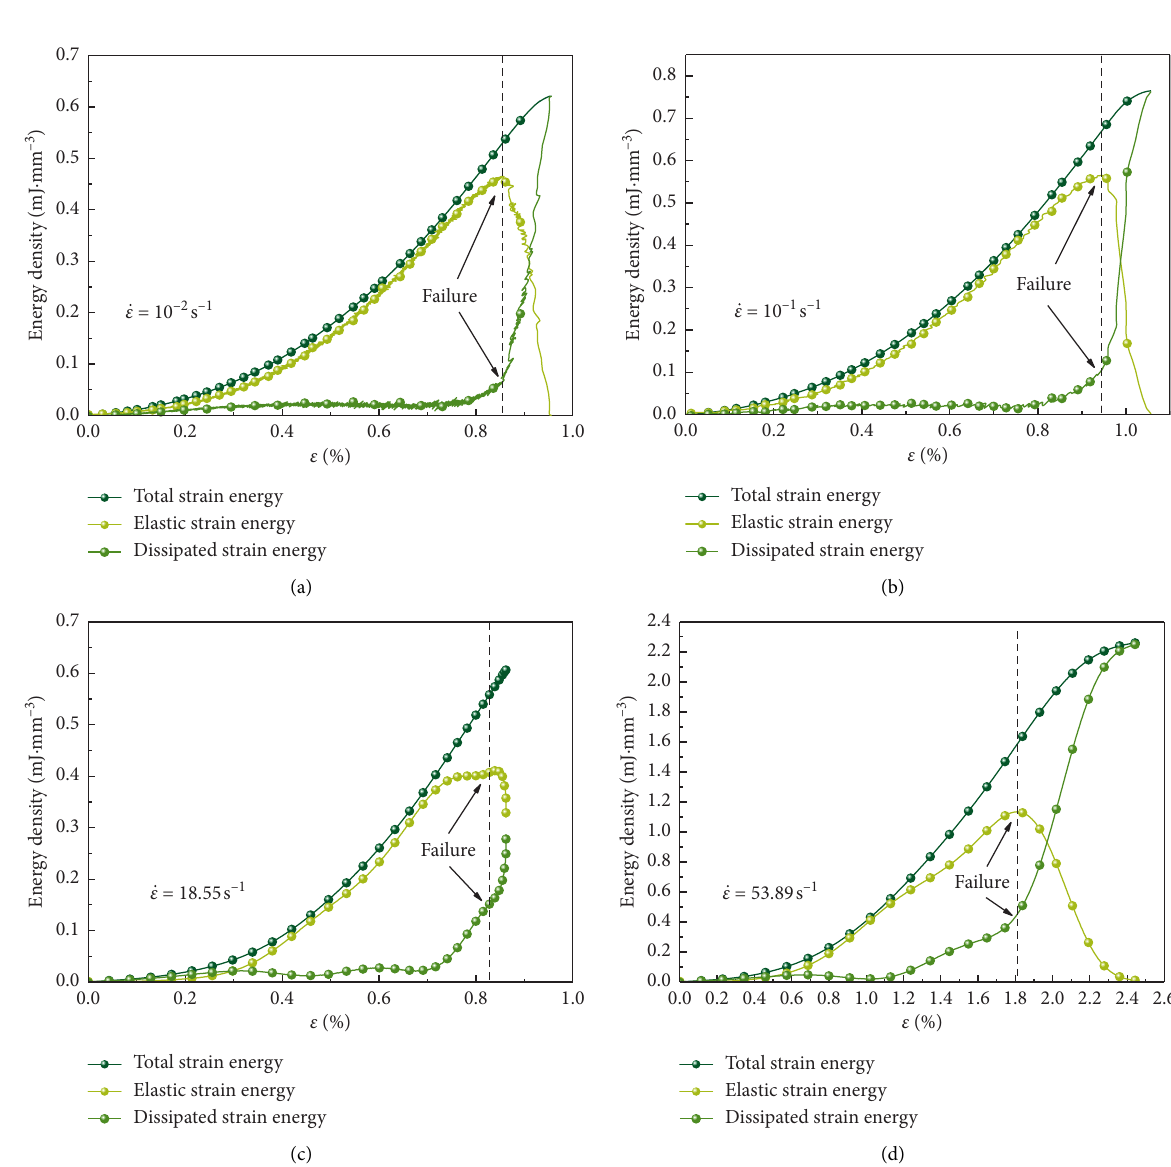
Figure 9: Energy evolution curves of sandstone samples at different strain